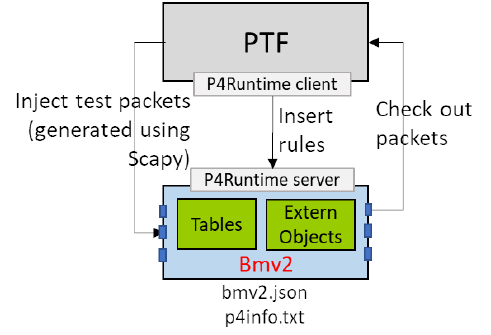
Figure 9. Unity test environment using the Plane Test Framework (PTF).